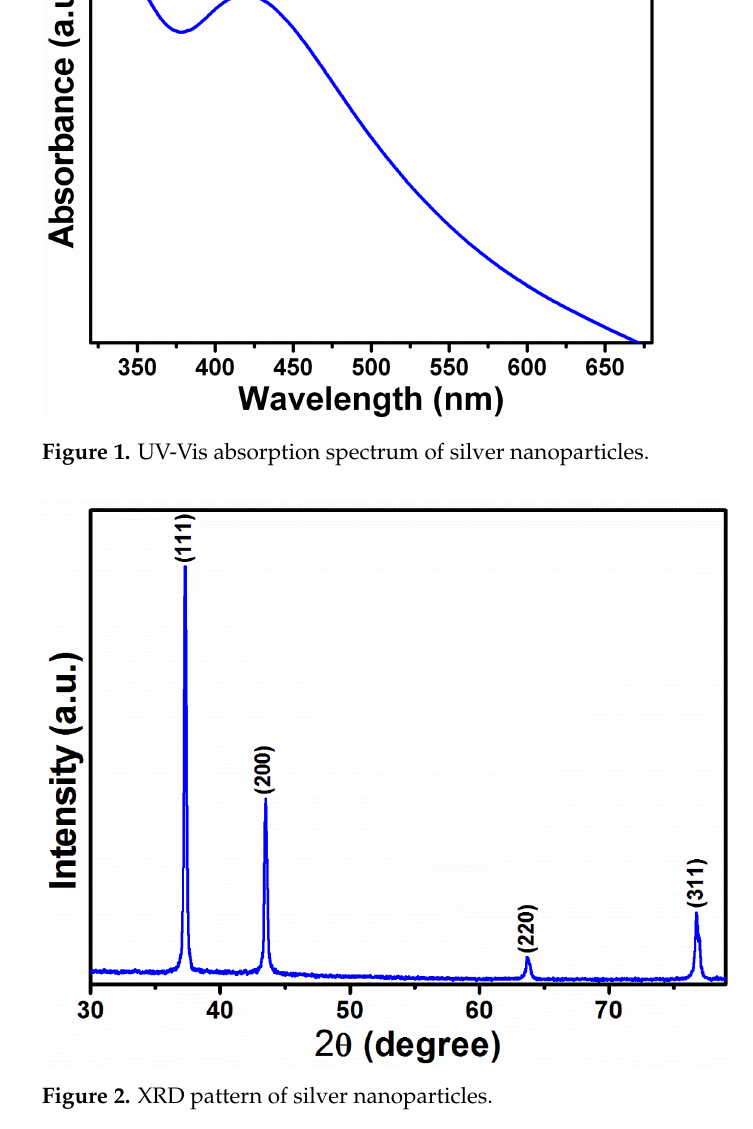
Figure 2. XRD pattern of silver nanoparticles.